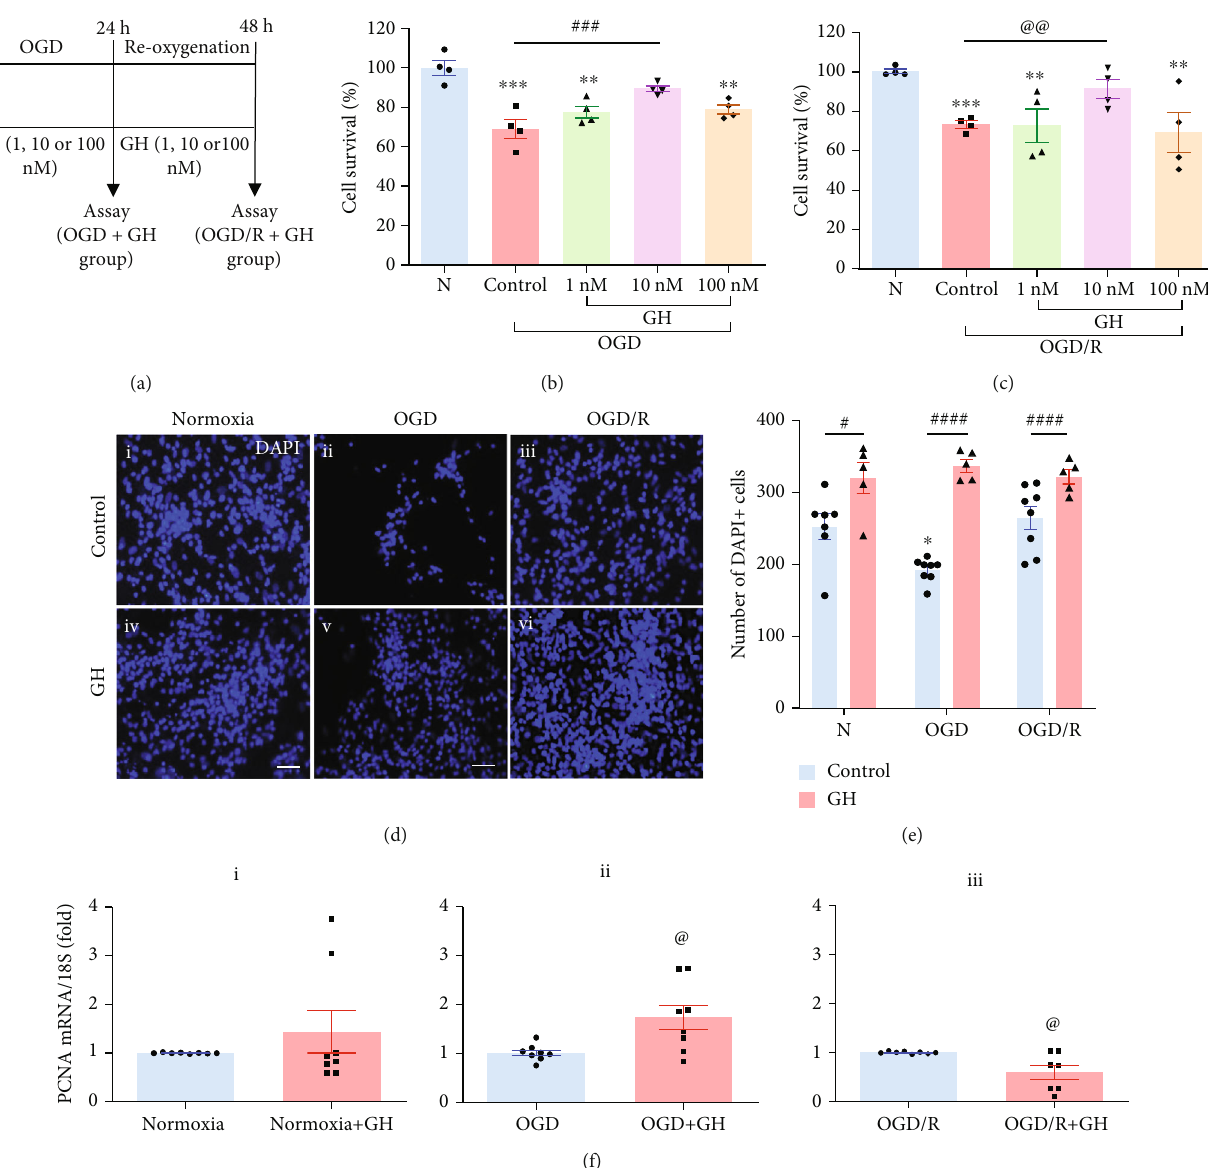
Figure 5: Neuroprotective e ff ects of growth hormone (GH) in hippocampal cell cultures exposed to OGD and reoxygenation (OGD/R) conditions. (a) Treatments and time course schematic representation of OGD and reoxygenation (OGD/R) protocols in the experimental groups. Cell survival was evaluated by the MTT assay in primary cultures treated with di ff erent doses (1, 10, 100nM) of GH and exposed to (b) OGD and (c) OGD/R incubation conditions. Bars represent mean ± SEM . Asterisks ( ∗ ) indicate signi fi cant di ff erences in comparison to control ( ∗∗ p < 0 : 01 ; ∗∗∗ p < 0 : 001 ), and number sign (#) shows di ff erences between experimental groups (###, p < 0 : 001 ) as assessed by one-way ANOVA and Tukey as posthoc test. An unpaired Student ’ s t -test was used to compare control versus 10nM GH (c), and the at sign (@) indicates a signi fi cant di ff erence (@@ p < 0 : 01 ). (d) Representative immuno fl uorescence images from each experimental group: (i) normoxia, (ii) OGD, (iii) OGD/R, (iv) normoxia + GH, (v) OGD + GH, and (vi) OGD/R + GH. Cell nuclei were stained with DAPI. Scale bar: 50 μ m. (e) Quanti fi cation of the number of cells stained with DAPI in each experimental group. Bars represent mean ± SEM . Asterisks ( ∗ ) indicate signi fi cant di ff erences in comparison to control ( ∗ p < 0 : 05 ), and number sign (#) shows di ff erences between experimental groups (# p < 0 : 05 ; #### p < 0 : 0001 ) as assessed by two-way ANOVA and Tukey as posthoc test. (f) Expression of PCNA mRNA, as determined by RT-qPCR in each experimental group: (i) normoxia, (ii) OGD, and (iii) OGD/R. Relative mRNA expression values were corrected by the comparative threshold cycle (Ct) method and employing the formula 2 − ΔΔ CT . Ribosomal 18S RNA was used as housekeeping gene. Bars represent mean ± SEM . The at sign (@) indicates a signi fi cant di ff erence in comparison to control (@ p < 0 : 05 ) as assessed by unpaired Student ’ s t